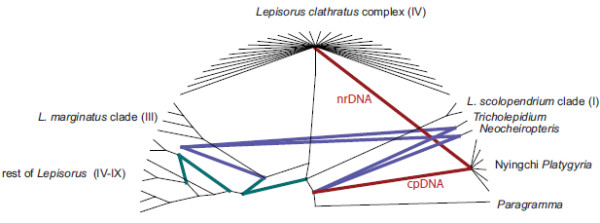
 Reticulogram obtained using Dendroscope based on the trees obtained from the three datasets (cpDNA, LFY and PgiC (full)). Red lines mark the heritage of the cpDNA and nrDNA found in Nyingchi Platygyria specimens (conflicting relationships with the Bayesian inference P-values ≥ 0.95 in cpDNA, LFY, and PgiC). Blue lines illustrate the heritage of the cpDNA and nrDNA of the genera Neocheiropteris and Tricholepidium (conflicting relationships with the Bayesian inference P-values ≥ 0.95 in cpDNA, LFY, and PgiC). Green lines indicate conflicting evidence at the base of the Lepisorus marginatus and the rest of Lepisorus clades (conflicting relationships partly caused by putative hybrid origin of L. marginatus and partly caused by lack of robust relationships) The relationships among specimens of the Lepisorus clathratus clade were collapsed to simplify the figure. Roman numbers correspond to clade numbers given in Wang et al.
[20].